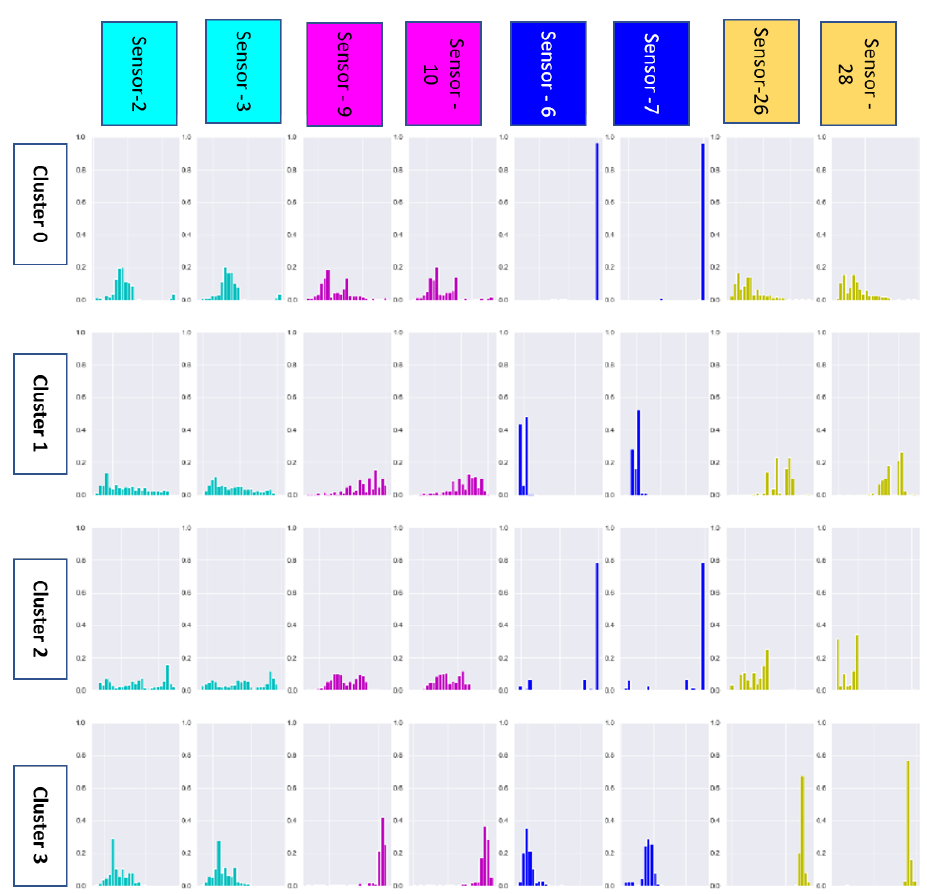
Figure 5. CPG of redundant